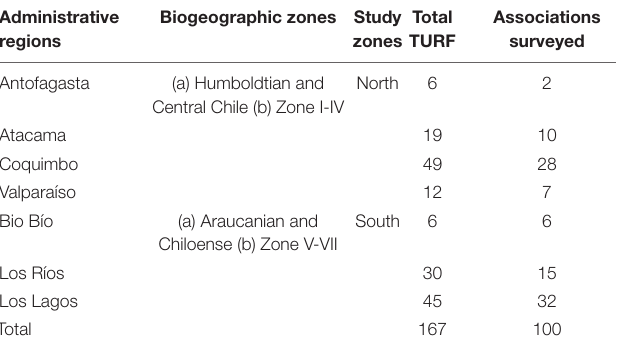
TABLE 1 | Characteristics of the management areas in the study